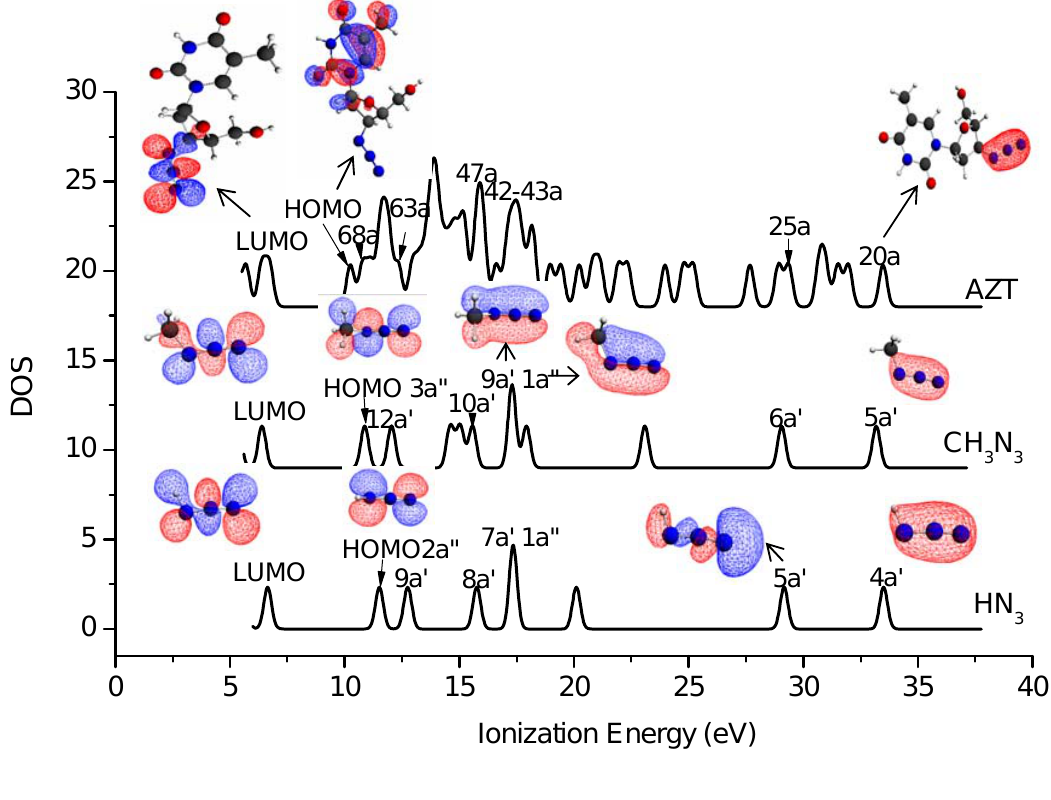
Figure 4. Simulated valence binding energy spectra (FWHM=0.40 eV) of AZT, CH and HN , based on SAOP/et-pVQZ calculations. The azide dominant orbitals are labeled in 3 the spectra with selected orbitals contour